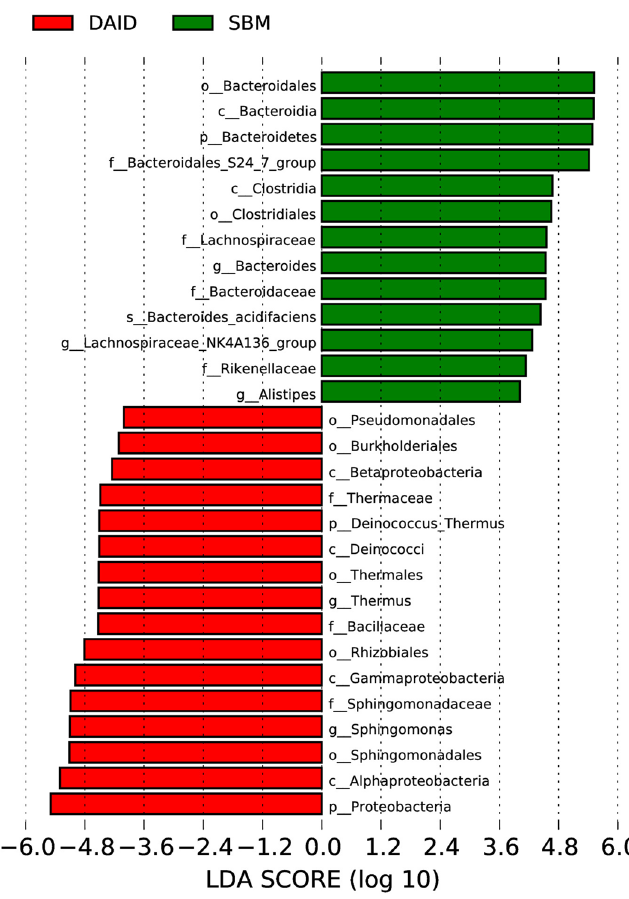
Figure 8. Linear discriminant analysis (LDA) score distribution bar graph of LEfSe analysis on intestinal microbiota of juvenile turbot. The LDA score greater than 4 was considered differentiated species. The letter (p, c, o, f, g and s) in front of phylotype names represented phylum, class, order, family, genus and species level respectively. The different colors of the bars indicated corresponding groups (red: DAID, green: SBM). SBM soybean meal diet, DAID 40 mg/kg daidzein included into SBM